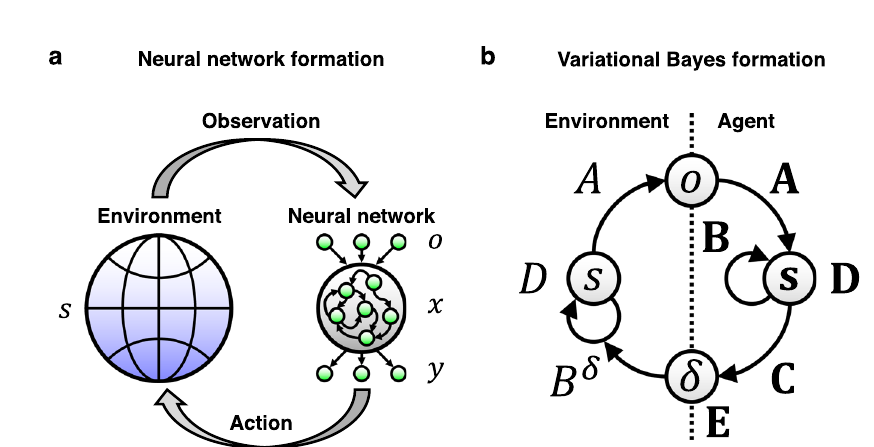
Fig. 1 Schematic of an external milieu and neural network, and the corresponding Bayesian formation. a Interaction between the external milieu and autonomous system comprising a two-layer neural network. On receiving sensory inputs or observations o ð t Þ that are generated from hidden states s ð t Þ , the network activity x ð t Þ generates outputs y ð t Þ . The gradient descent on a neural network cost function L determines the dynamics of neural activity and plasticity. Thus, L is suf fi cient to characterise the neural network. The proposed theory af fi rms that the ensuing neural dynamics are self-organised to encode the posterior beliefs about hidden states and decisions. b Corresponding variational Bayesian formation. The interaction depicted in a is formulated in terms of a POMDP model, which is parameterised by A ; B ; C 2 θ and D ; E 2 λ . Variational free energy minimisation allows an agent to self-organise to encode the hidden states of the external milieu — and to make decisions minimising future risk. Here, variational free energy F is suf fi cient to characterise the inferences and behaviours of the